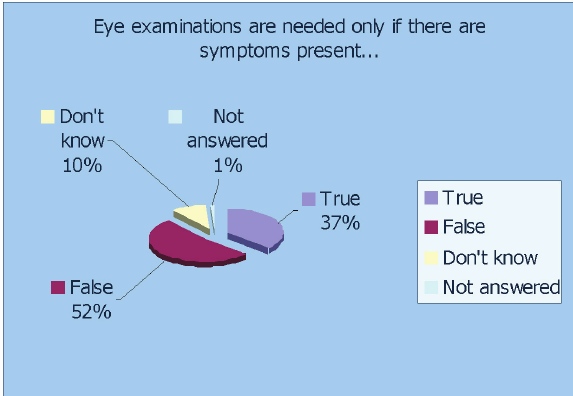
Figure 7 . Patient views on ocular symptoms and the need for eye